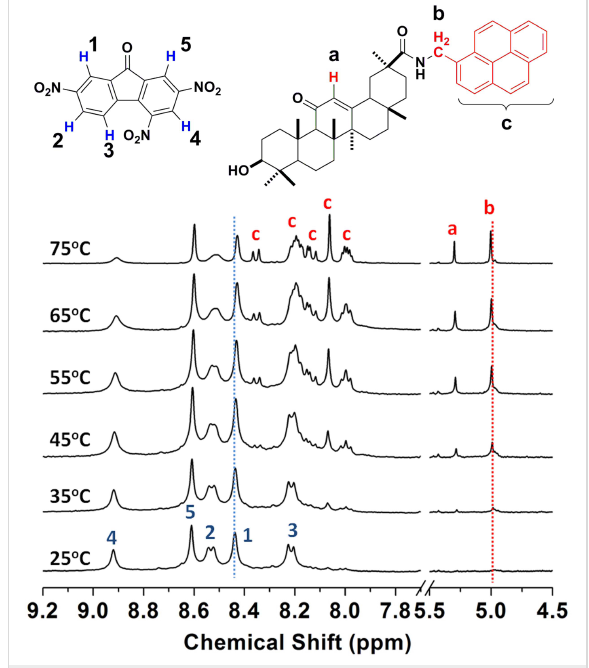
Figure 8: Variable temperature 1 H NMR (400 MHz) of CT gel ( 3 and 4 , 1:1, molar ratio) in DMSO/D 2 O (3:1, v/v). [ 3 ] = 9 mM.